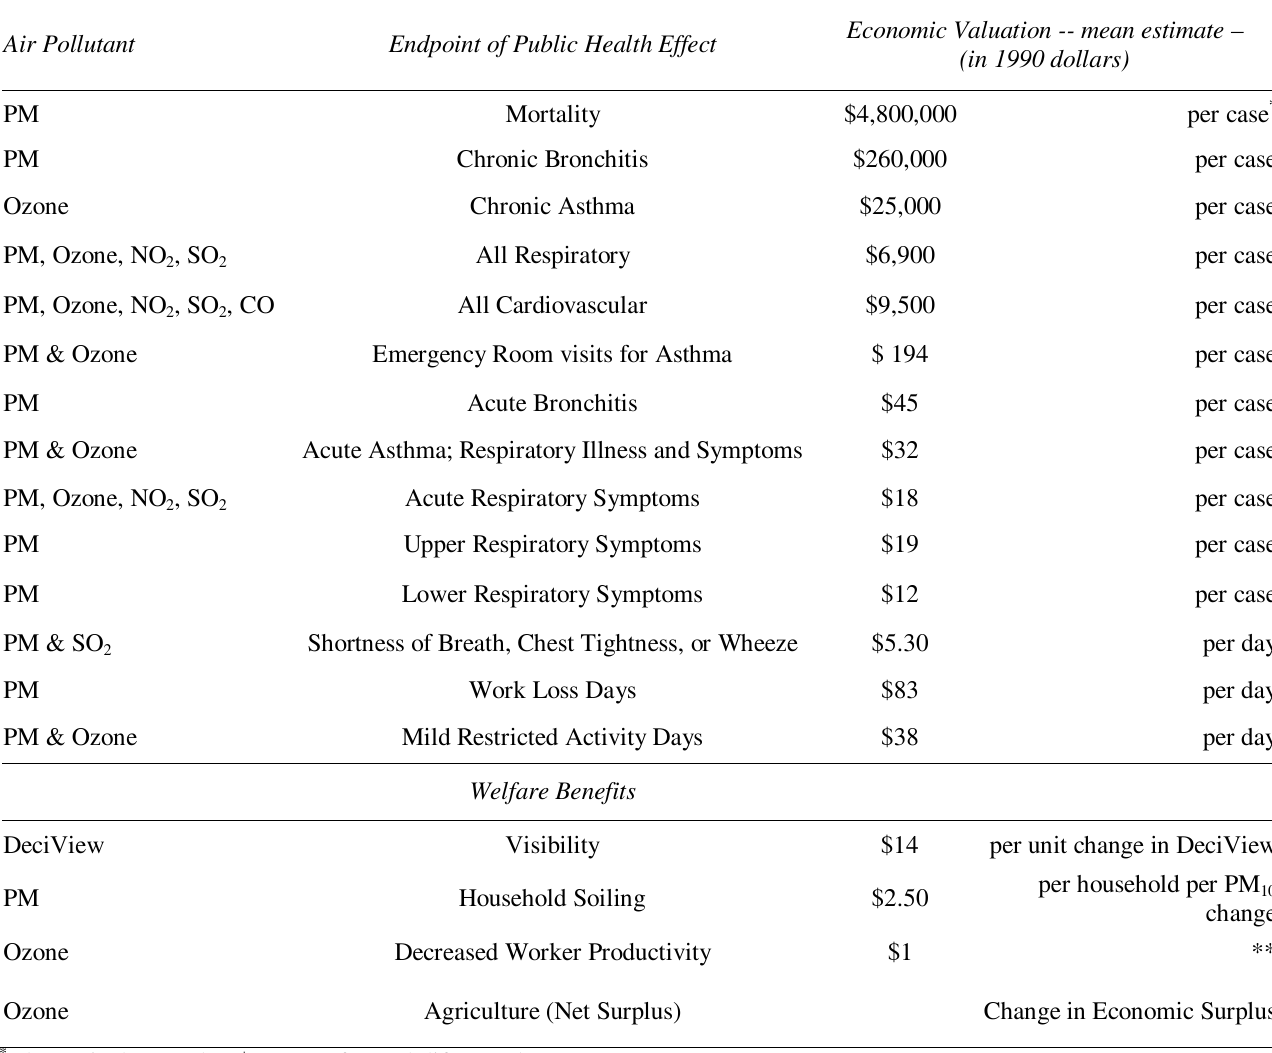
Table 1: Major air pollutants and their effects on public health [22,